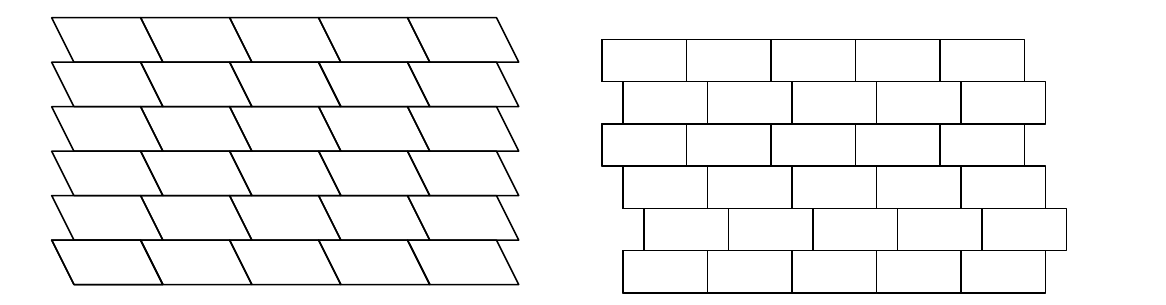
Fig. 52: Tiling with two types of rectangles. Fig. 53: Tiling with one type of trapezoid.